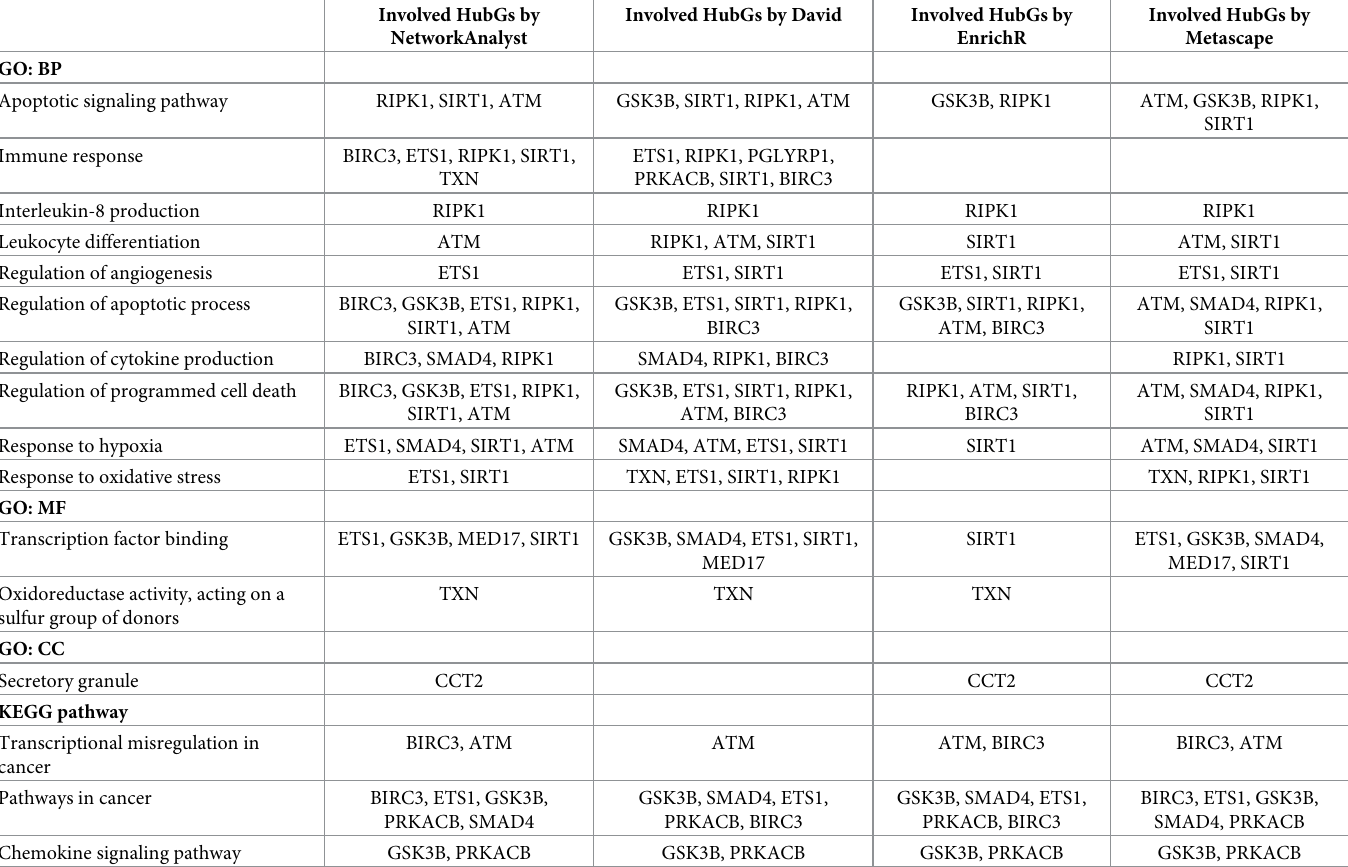
Table 1. Significantly enriched GO terms and KEGG pathways with DEGs by involving HubGs in four different databases that are involved in the pathogenetic pro- cesses of SARS-CoV infections (p-value < 0.05). Involved HubGs by Involved HubGs by David Involved HubGs by Involved HubGs by NetworkAnalyst EnrichR